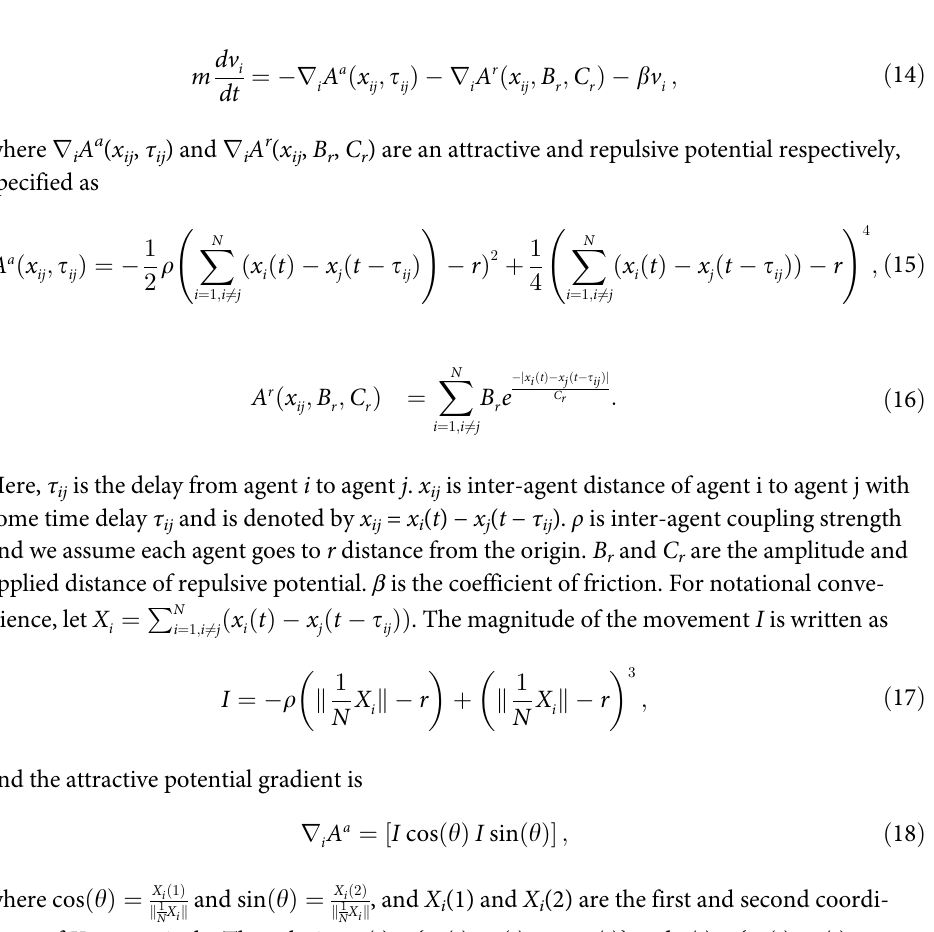
ffiffiffiffiffiffiffiffiffiffiffiffiffiffiffiffiffiffiffiffi p , where R þ R 2 R 2 CX CY